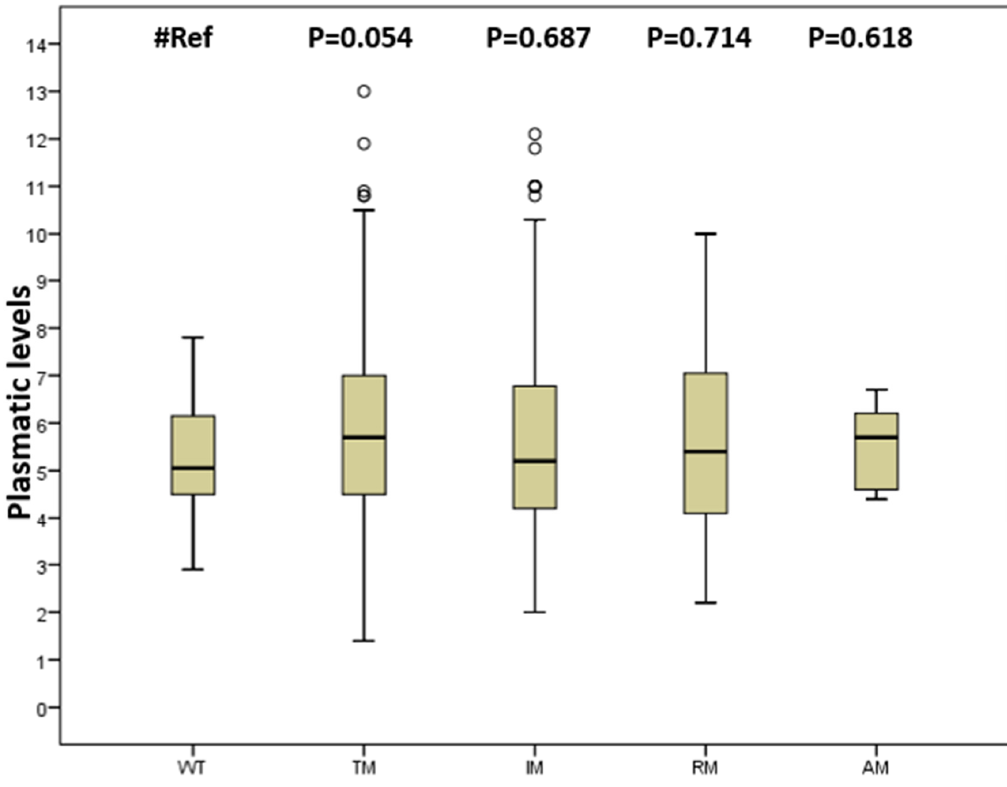
Figure 1. Tacrolimus blood levels stratified by group of gene mutation. WT: wild type; IM: mutations